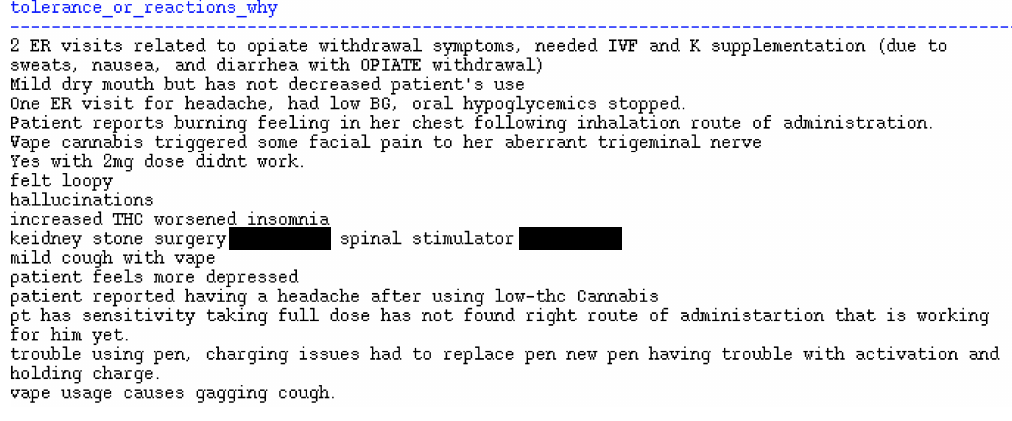
Figure A3. Documentation of Adverse Drug Reactions to Cannabis or Other Patient-Reported Problems with Treatment During Follow-Up Visits; N = 16 entries.